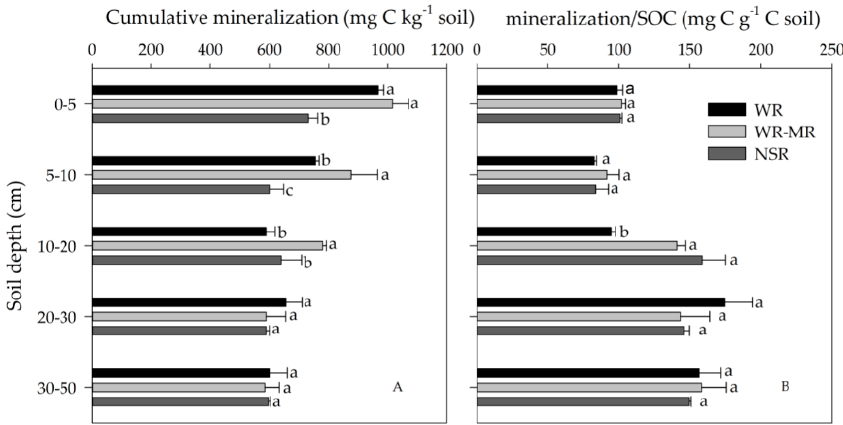
Figure 2. Effects of straw return modes on cumulative mineralization ( A ) and SOC/mineralization ( B ). NSR, no straw returning; WR, only wheat straw returning; WR-MR, both wheat and maize straw returning. Lower case letters indicate significant differences ( p < 0.05) among different treatments within the same soil depth. Error bars indicate SD.